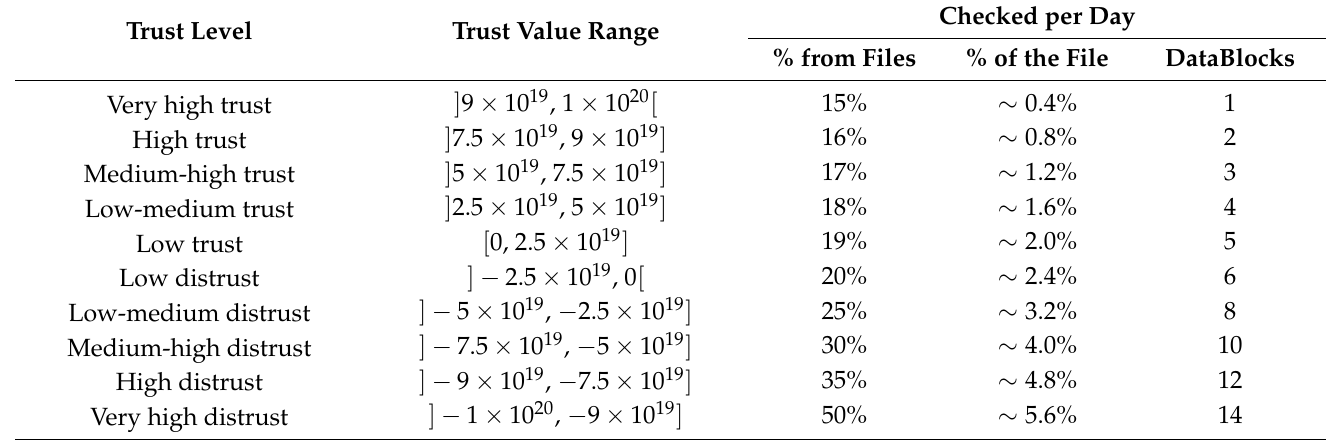
Table 2. Trust level classification